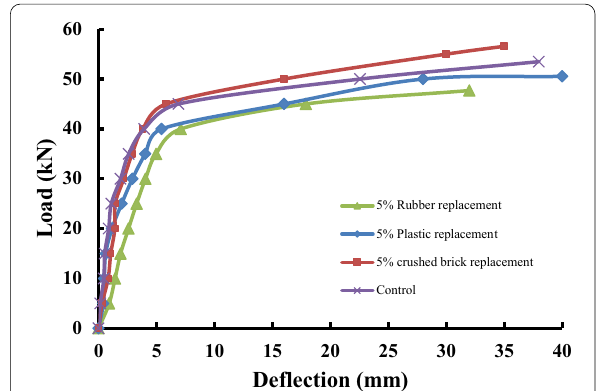
Fig. 13 Load–deflection for beams with crumbed rubber waste.